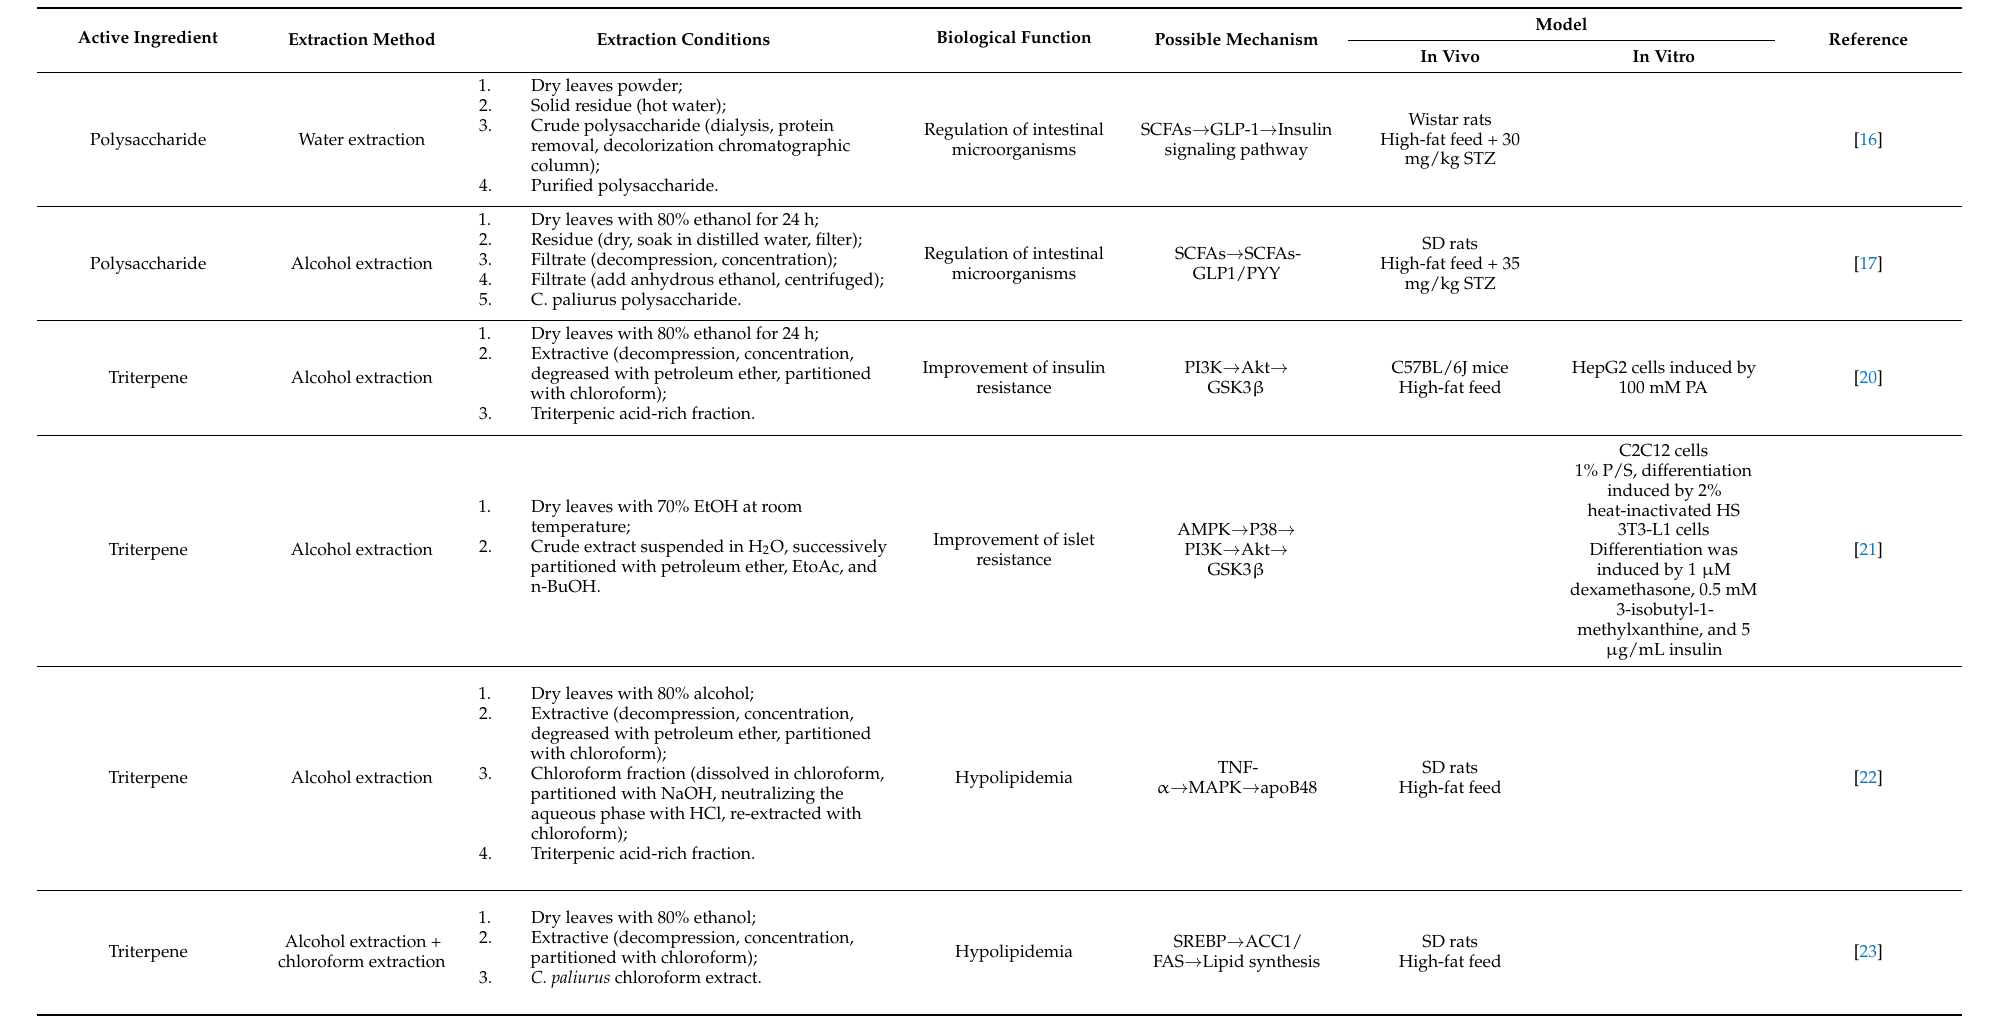
Table 1. The mechanism of action of the different Cyclocarya paliurus extracts on type 2 diabetes